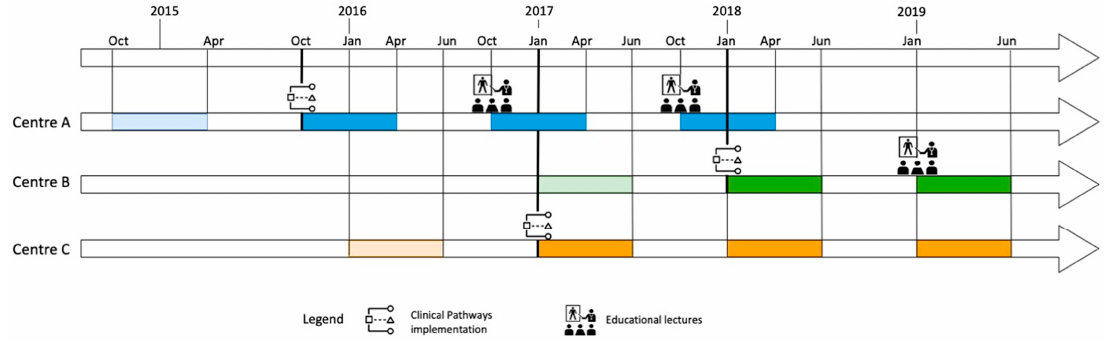
Figure 3. Study flow chart of the ASPs’ implementation in the three centers.